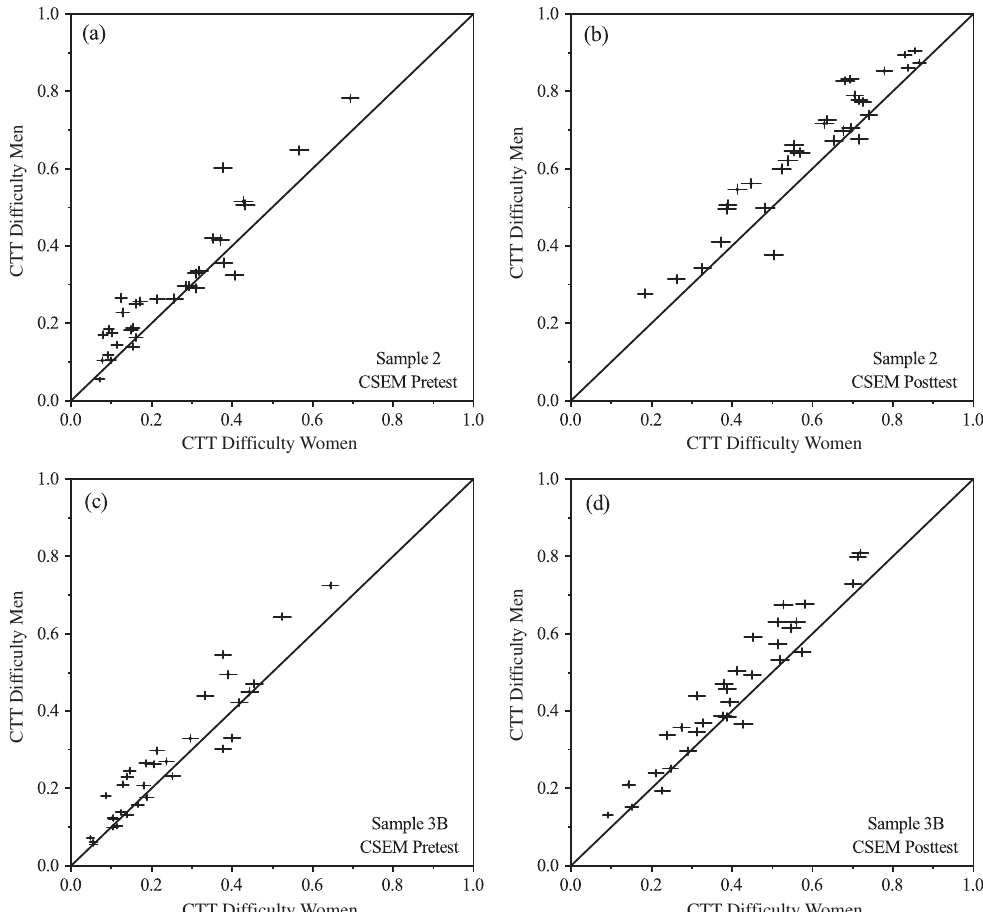
FIG. 3. CTT difficulty results for the CSEM. The top two panels are sample 2 (a) CSEM pretest and (b) CSEM post-test. The bottom two panels are sample 3B (c) CSEM pretest and (d) CSEM post-test. A line of slope 1 is drawn to allow comparison of male and female difficulty. Error bars represent 1 standard deviation in each direction.